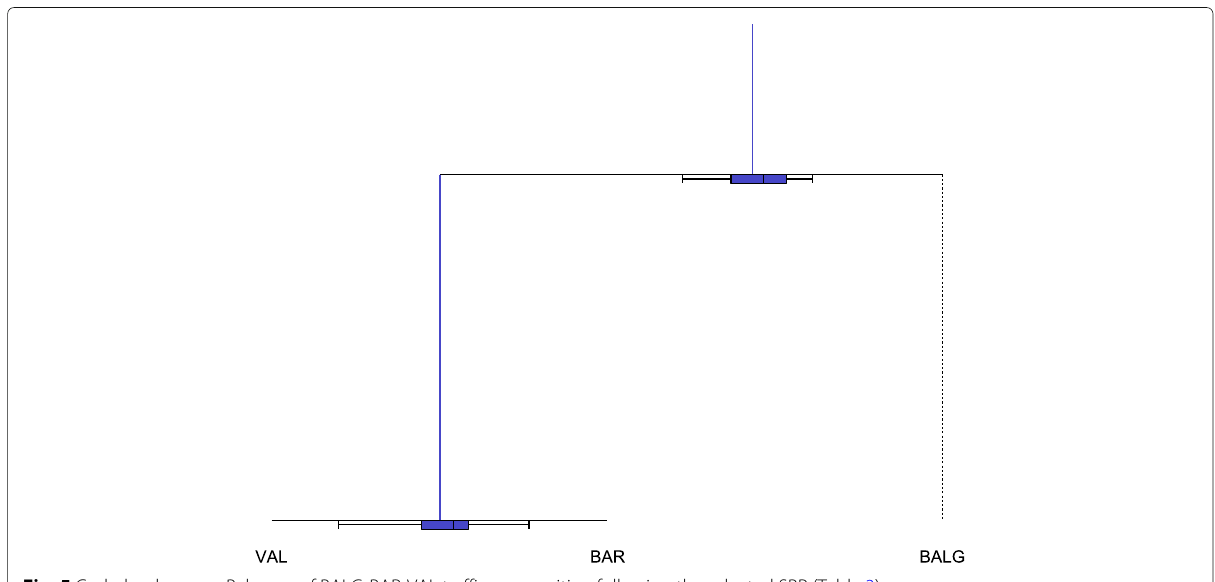
Fig. 5 Codadendrogram. Balances of BALG-BAR-VAL traffic composition following the selected SBP (Table 3)